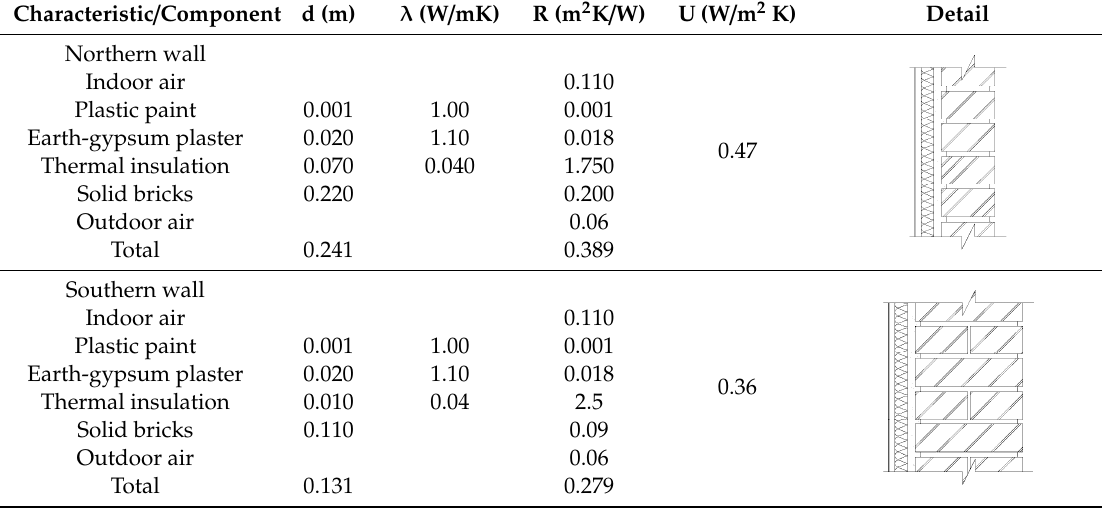
Table 5. Specifications of the building elements after auditing.